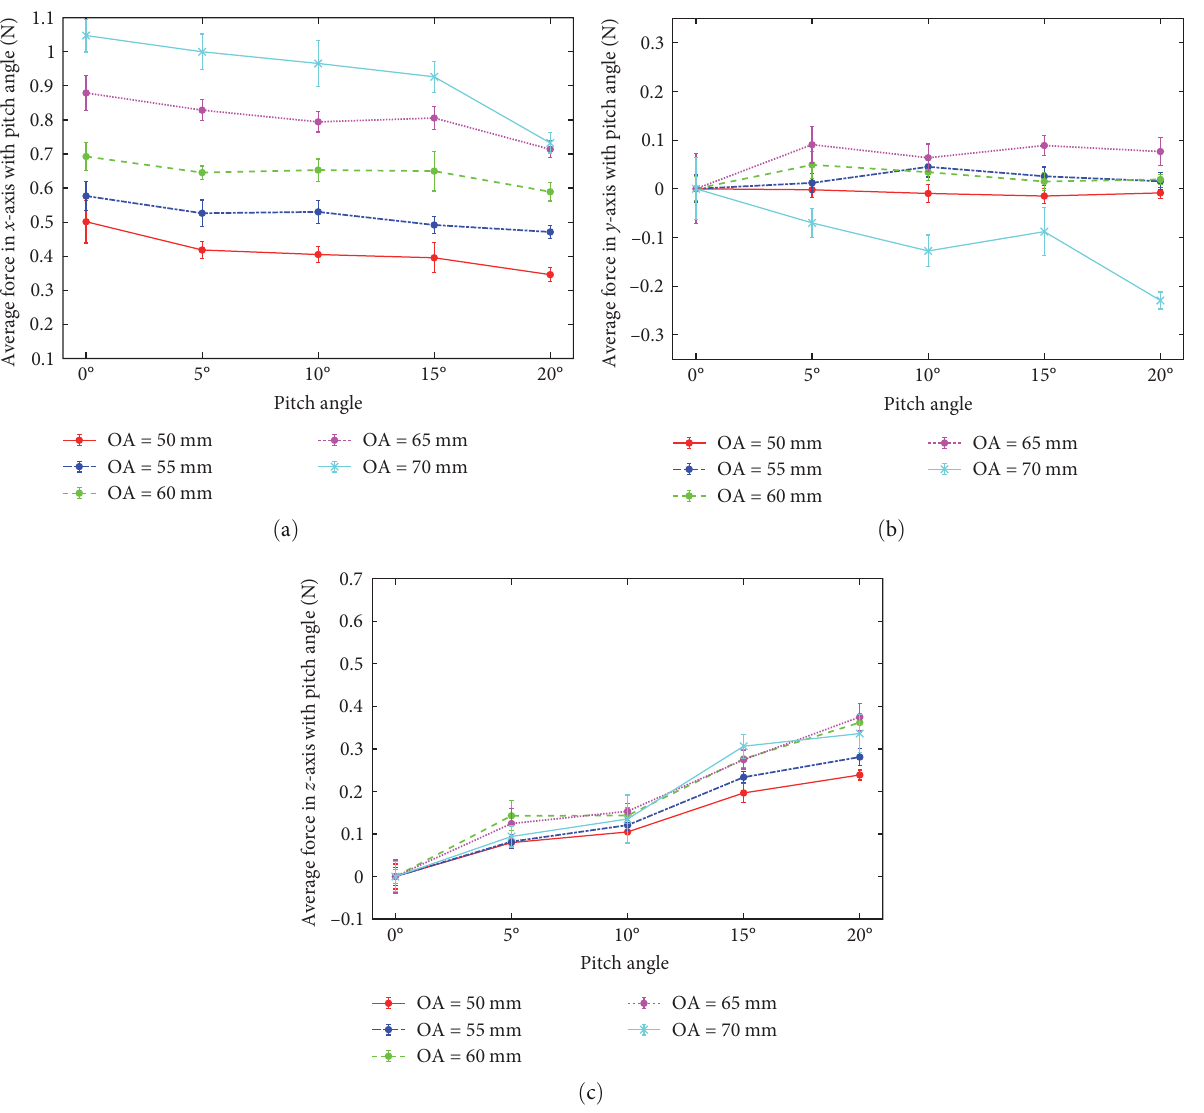
F IGURE 7: F xP ; F yP , and F zP over pitch angle with no wave and no